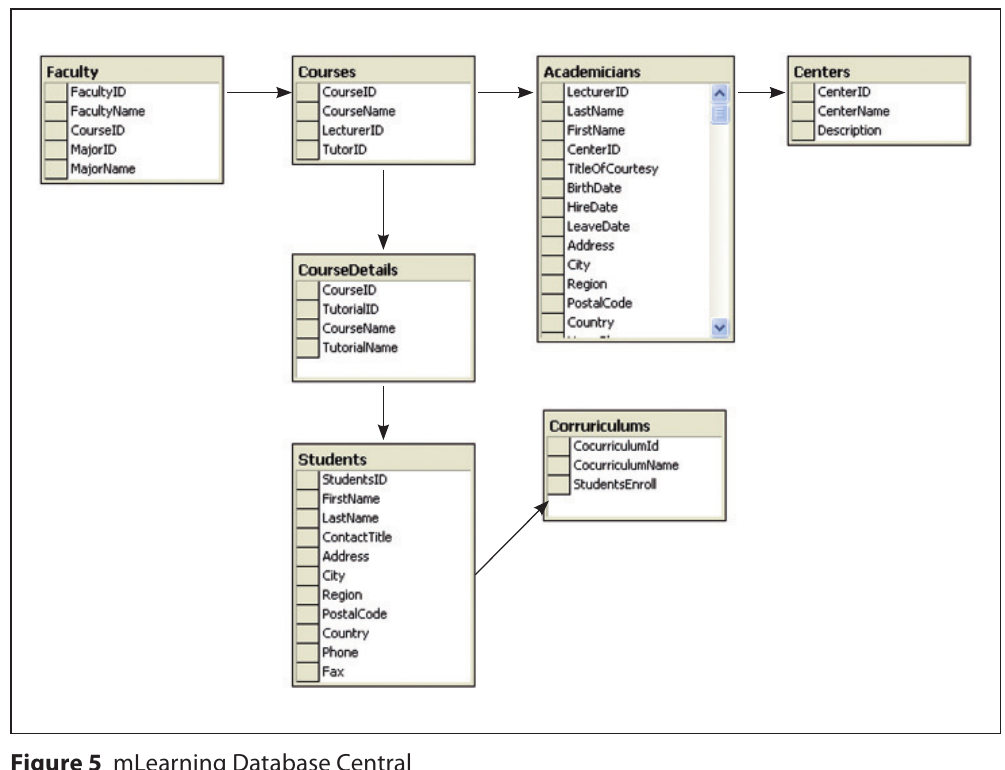
Figure 5 mLearning Database Central